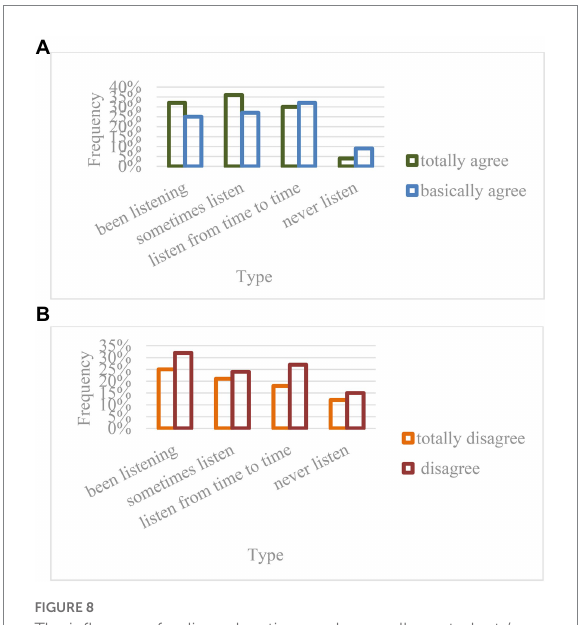
FIGURE 8 The influence of online education mode on college students’ will. (A) Freshmen. (B) Senior students.